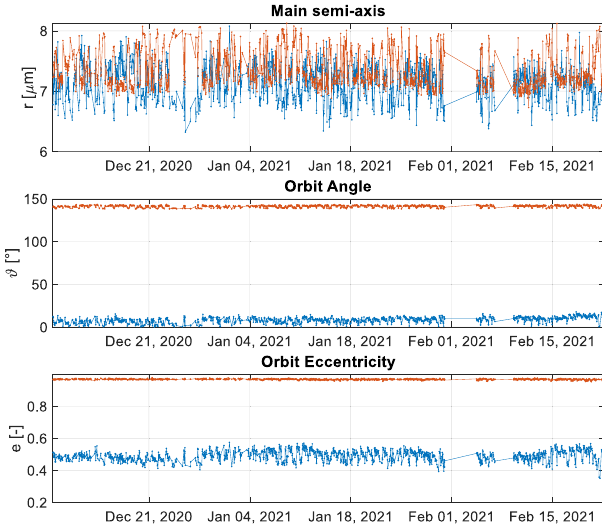
Fig. 11. Amplitude spectra of the x and y relative displacements with highlighted the selected fi lter for the 2 (cid:4) orbit.